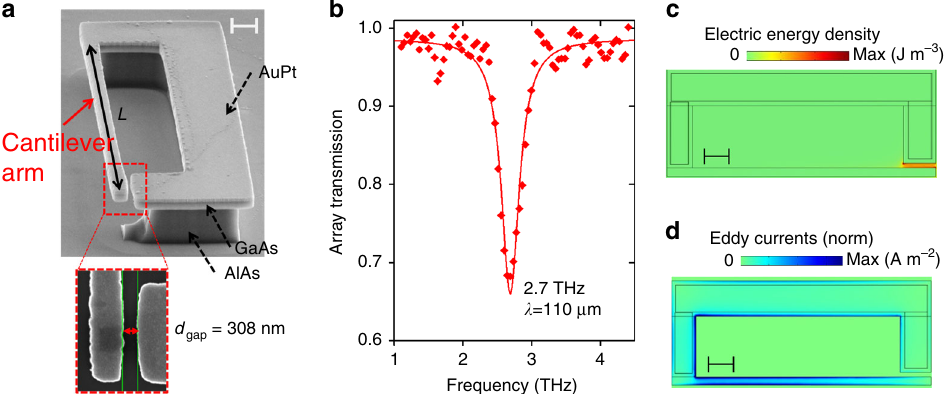
Fig. 1 Optomechanical terahertz resonator and optical characterizations. a Side view of the split-ring resonator (SRR) obtained with a scanning electron microscope. The blown-up image shows the capacitive gap between the cantilever arm and the rest of the SRR. The scale bar indicated in the upper right corner of the image is 1 µ m wide. b Far-infrared transmission spectrum of an array of identical SRRs. The dots are experimental measurements and the line is a Lorentzian fi t. c Distribution of the electric energy density in the SRR, obtained with a fi nite difference domain simulator. d Illustration of the normalized THz eddy currents induced in the metal layers at resonance. The scale bar indicated in c , d is 2 µ m